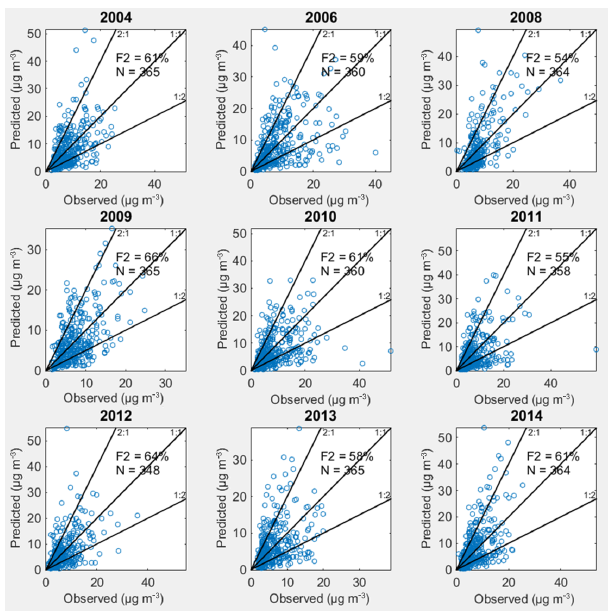
Figure 2. The scatter plots of measured and predicted daily aver- age concentrations of PM 2 . 5 at the station of Luukki, for the period 2004–2014. The factor-of-2 values and the numbers of measured days have also been presented in the